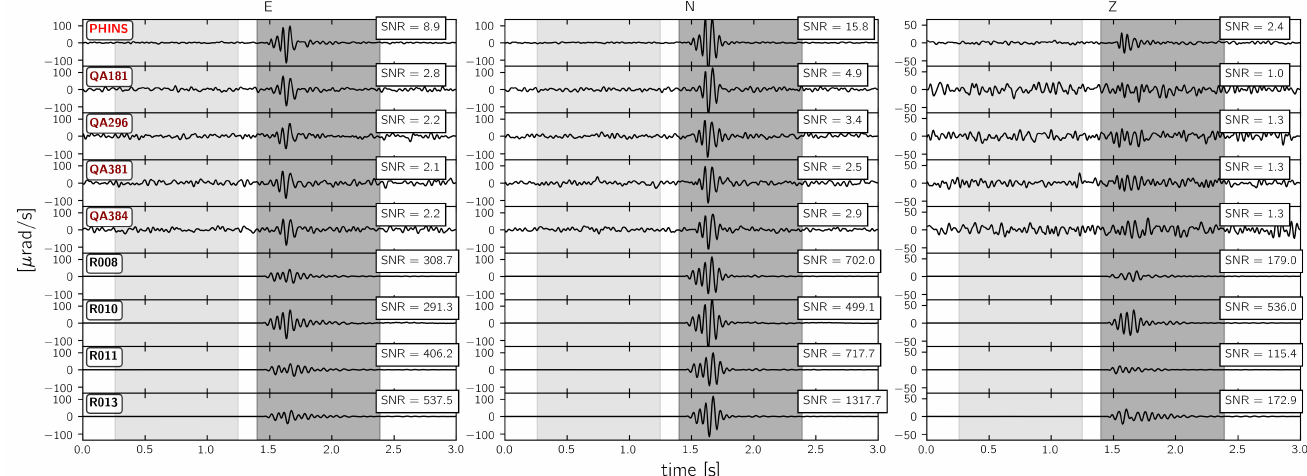
Figure 11. 30Hz low pass filtered waveforms from “expl2” (see Figure 1) recorded by 6C strong motion sensors as well as the Rotaphone-CY systems. See Figure 9 for more